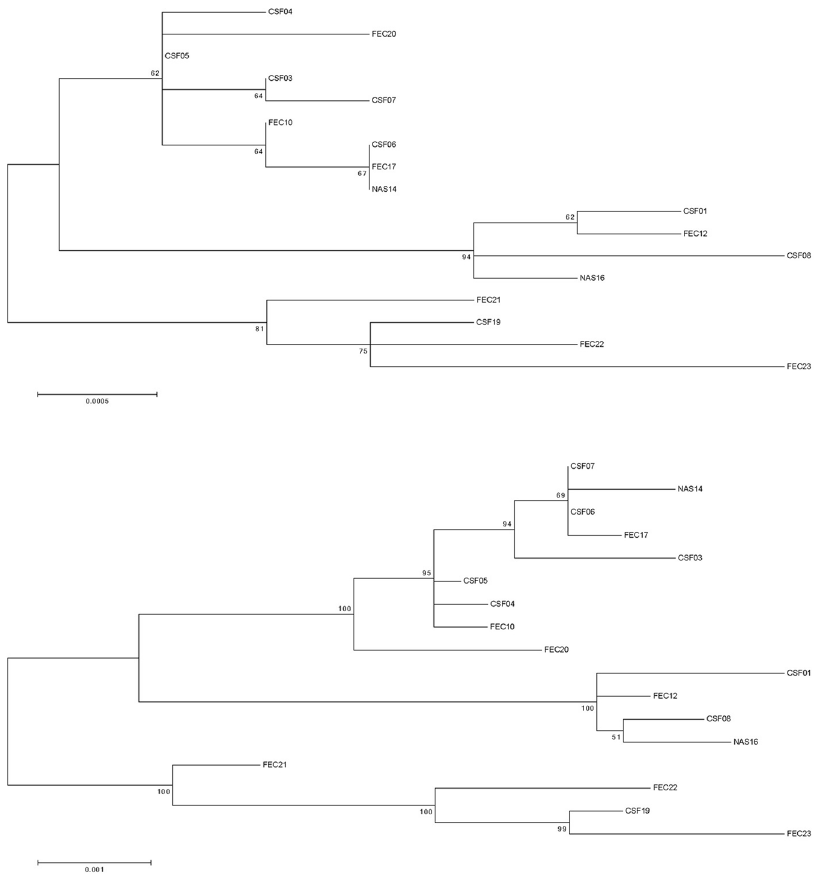
Figure 2. Maximum Likelihood (ML) phylogenetic trees based on either the capsid or nonstructural proteins encoding region of the 17 Australian 2013–2015 HPeV3 sequences. Sequences were aligned using Clustal W and phylogenetic analysis was conducted using MEGA version 6 and the Maximum Likelihood (ML) method. The tree with the highest log likelihood is shown. Bootstrap test involved 1000 replicates to determine reliability of the inferred tree. The numbers at nodes represent bootstrap values. Branch lengths are scaled according to the numbers of nucleotide substitutions per site. (A) Midpoint rooted tree based on the capsid encoding region from nucleotide 701–3013. (B) Midpoint rooted tree based on the nonstructural proteins encoding region from nucleotide